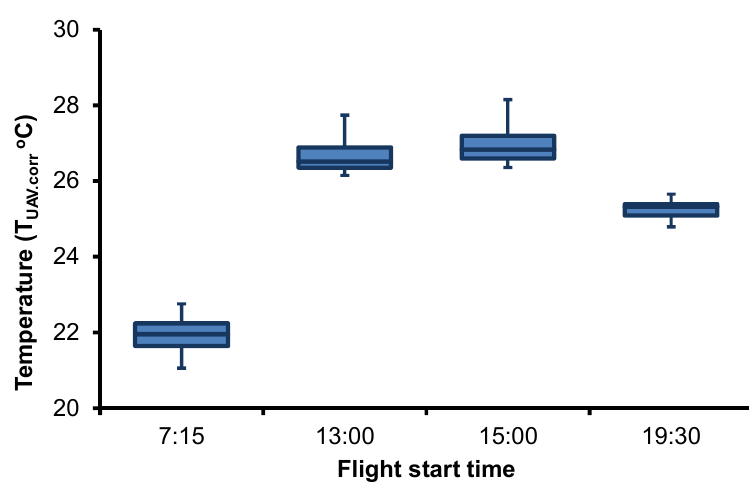
Figure 5. Temperature maps of the side channel in the floodplain of the river derived from uncorrected thermal imagery (°C, T UAV ) during the morning (07:15), mid-day (13:00 and 15:00) and evening (19:30). Note the different color scales across the individual maps.